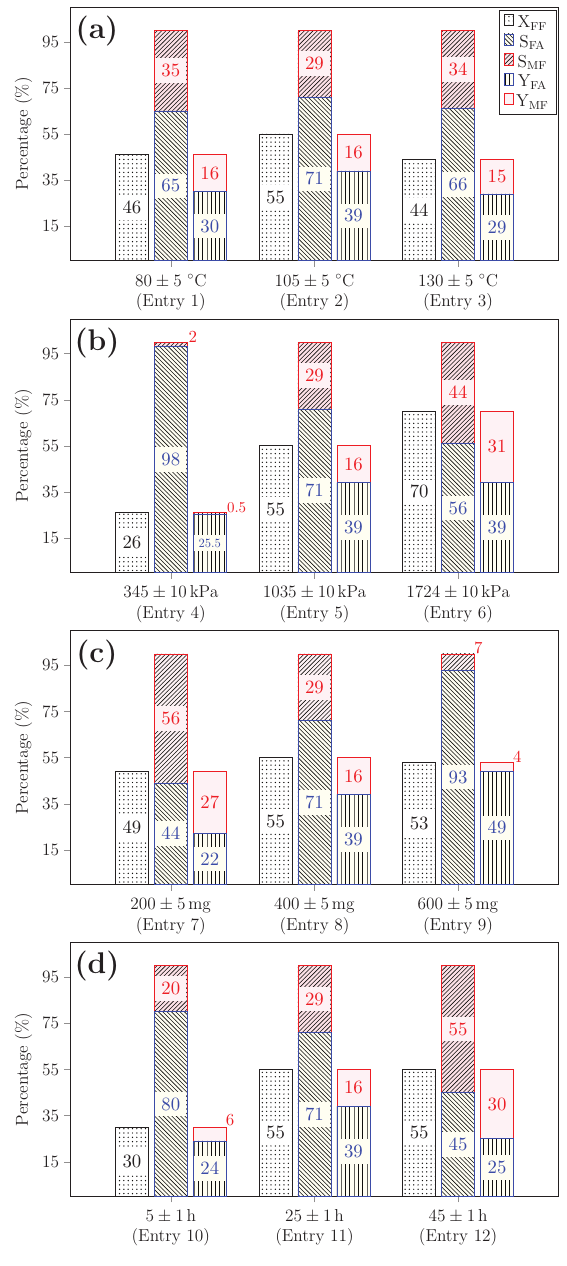
Figure 6. Hydrogenation of furfural (1g FF in 50mL H ), using sample “R-Ru-OBC” under different 2 O = 1035kPa, m cat. = 400mg, t = 25h. reaction conditions of: ( a ) temperature (T), (80 to 130 ◦ C), P i H 2 ( b ) hydrogen pressure, (P i ) (345 to 1724kPa), T = 105 ◦ C, m cat. = 400mg, t = 25h. ( c ) mass of catalyst H 2 = 1035kPa, t = 25h. ( d ) time (t), 6.5 mm (5 to 45h), T = 105 ◦ C, (m cat. ), (200 to 600mg), T = 105 ◦ C, P i H 2 = 1035kPa, m cat. = 400mg. (cid:63) Notations: P i P i : initial H 2 pressure, X FF : furfural conversion, S FA : H 2 H 2 selectivity of furfuryl alcohol, S MF : selectivity of 2-methylfuran, Y FA : yield of furfuryl alcohol, Y MF : yield of